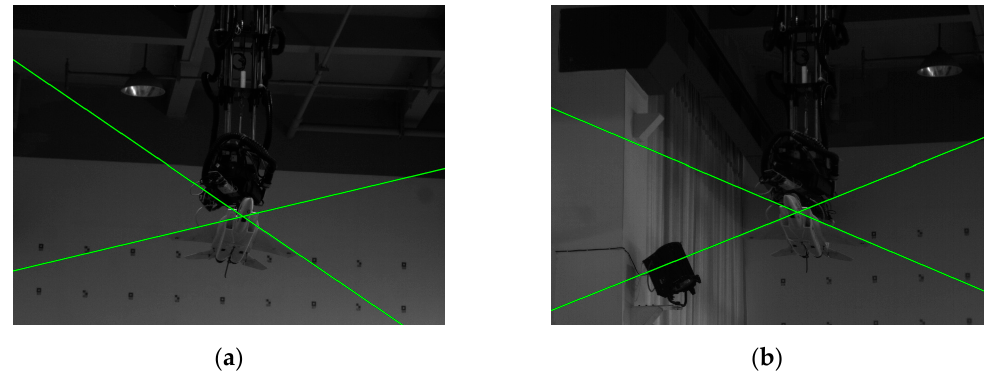
Figure 17. Wing leading edge extraction results on a real image pair of the aircraft model: ( a ) the real image captured by the left camera; ( b ) the real image captured by the right camera.